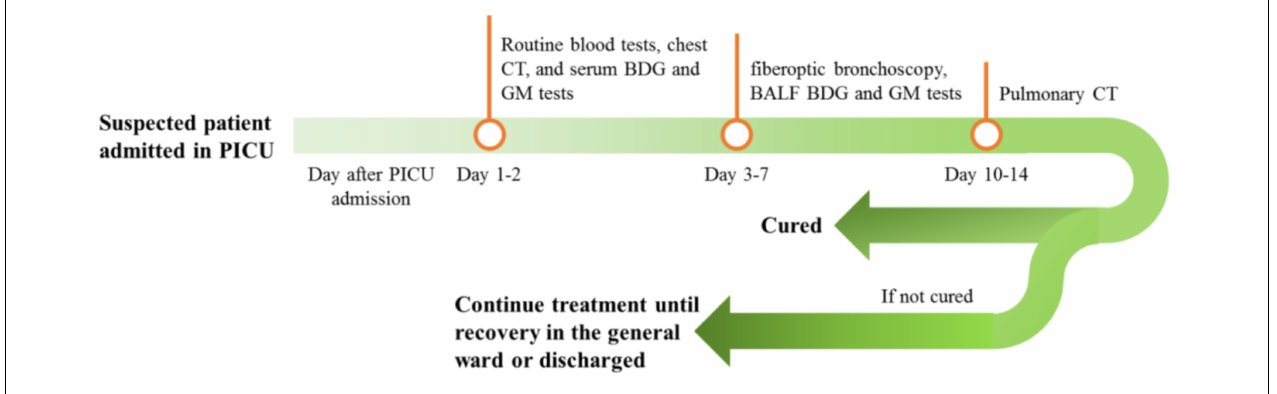
FIGURE 1 | Patient admission process.